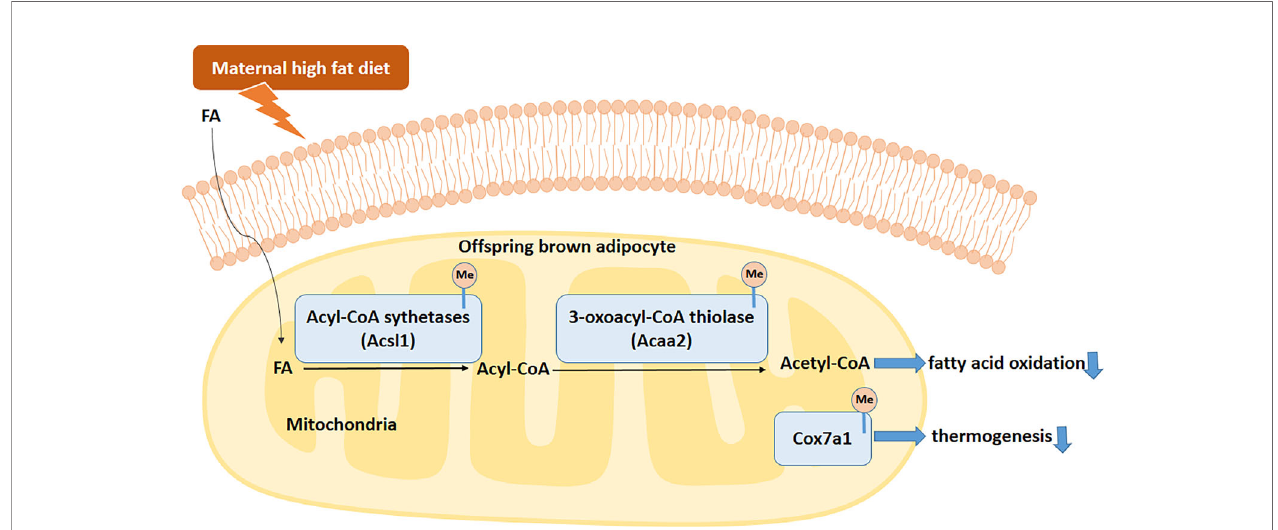
FIGURE 9 | Proposed mechanism by which maternal HFD disrupts brown adipose tissue (BAT) fatty acid oxidation (FAO) and thermogenesis in male offspring. Fatty acids (FAs) enter brown adipocytes and are activated by acyl-CoA sythetases, including Acsl1 , to form acyl-CoAs. Then acyl-CoAs were catabolized to acetyl-CoAs by acyl-CoA dehydrogenases, such as Acaa2 . Maternal HFD active the methylation of offspring BAT FAO related enzymes, such as Acsl1 and Acaa2 . Meanwhile, Cox7a1 gene methylation in offspring BAT was also active by maternal HFD. To sum up, maternal HFD disturbs the BAT FAO and thermogenesis through activated speci fi c gene DNA methylation. FA, fatty